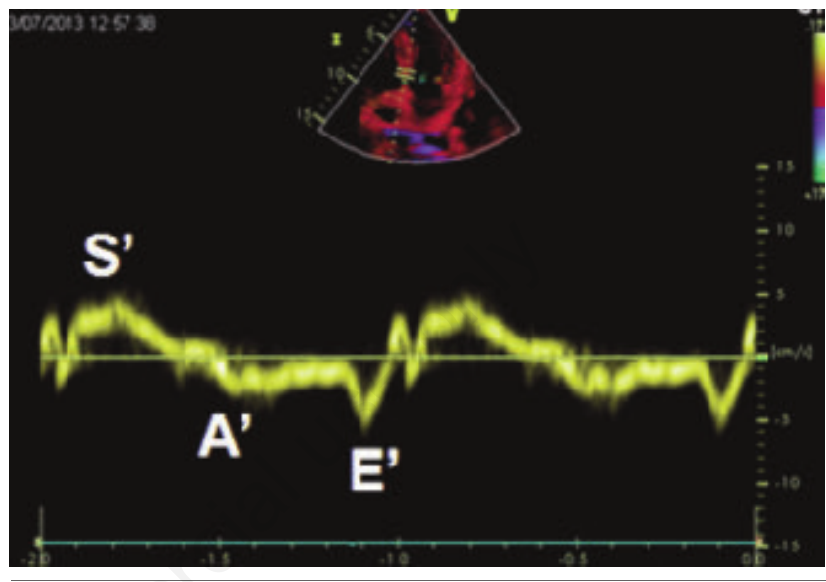
Figure 3. Reduced systolic velocity (S') and altered diastolic patterns (inverted ratio A'/E') at the level of the basal segment of the interventricular septum in patients with hyper- trophic cardiomyopathy.